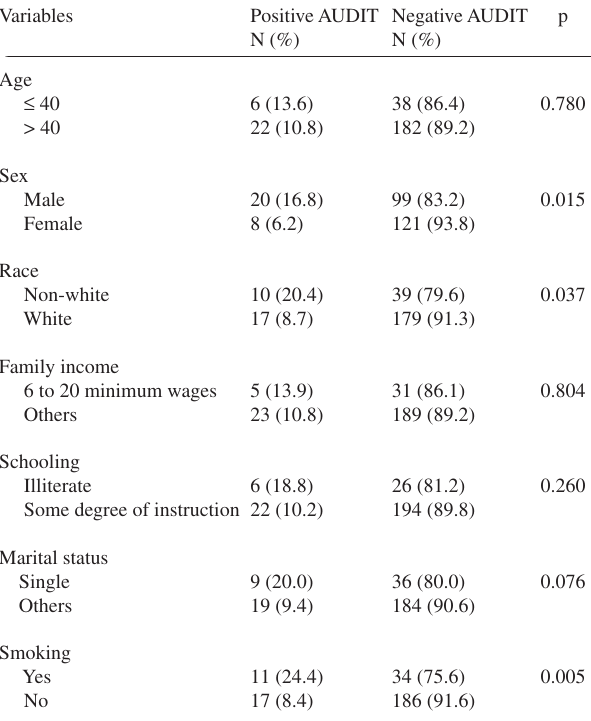
Table 1 - Social and demographic characteristics of patients with a positive Alcohol Use Disorders Identification Test (AUDIT) and a negative Alcohol Use Disorders Identifica-